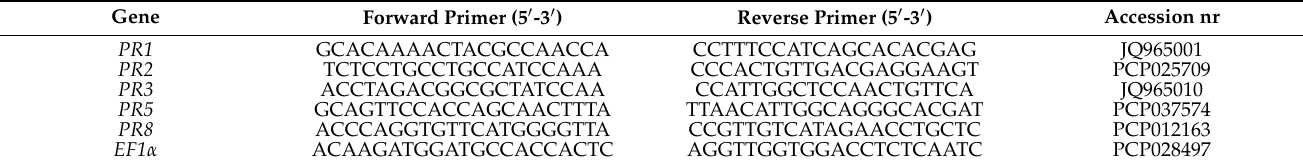
Table 1. Primers used in this study. PR: Pathogenesis-Related proteins; EF1 α : Elongation Factor 1